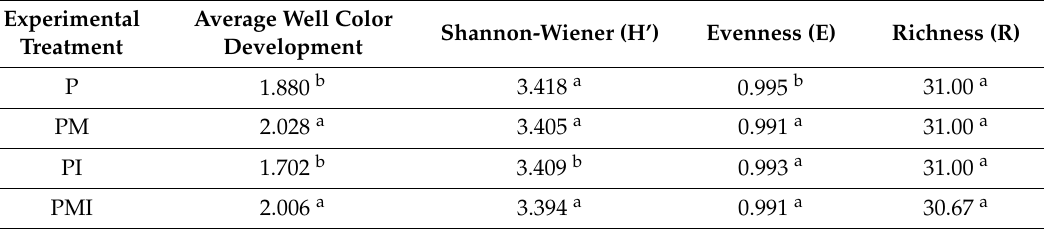
Table 4. Functional diversity indices evaluated based on substrate utilization after 96 h in Biolog EcoPlates calculated for the data from all 31 carbon sources (±SD). Different letters indicate significant differences between the cultivars ( p ≤ 0.05, n = 3).